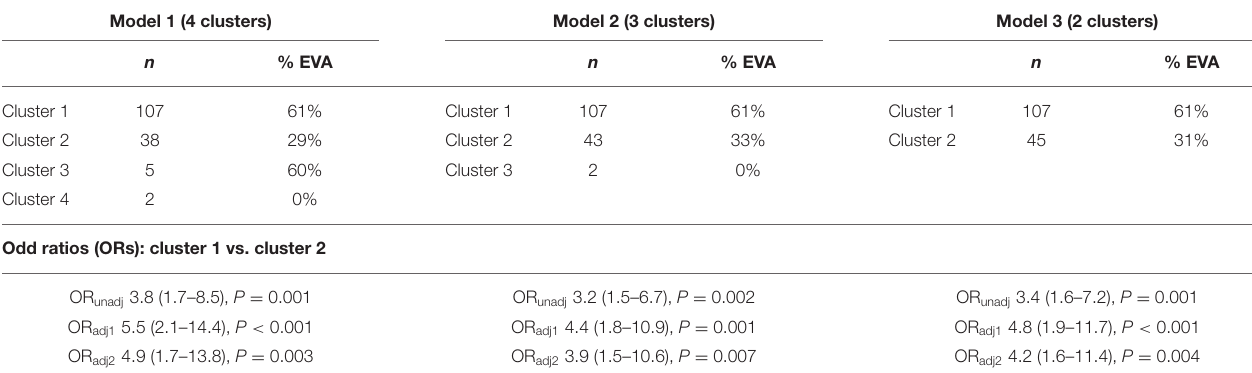
TABLE 3 | Rates of EVA syndrome in clusters generated by an unsupervised hierarchical clustering, and unadjusted and adjusted ORs of EVA. Model 1 (4 clusters)